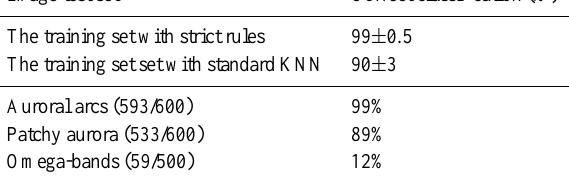
Table 1. The experimental error determined by comparing man- ual and automatic classification. First, all images in the training set (258 images) were classified automatically and the results were compared to their class label. Then, using the results from the auto- matic classification, 1700 randomly chosen images labelled as arcs (600 images), patchy auroras (600 images) and Omega-bands (500 images) were manually re-classified to determine the accuracy.